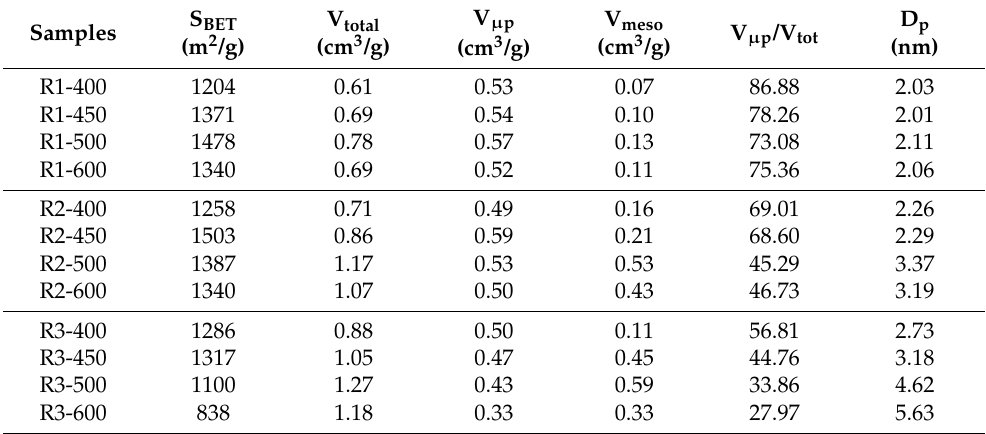
Table 3. Textural properties of the obtained activated carbons produced at different activation conditions.